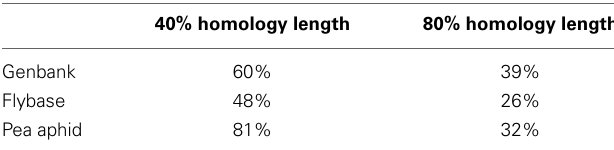
Table 1 | Summary statistics of Zyginidia transcripts homology